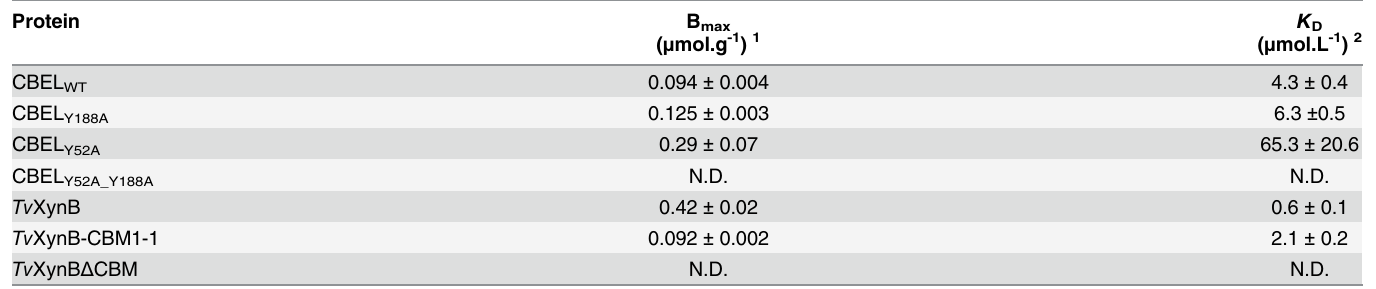
Table 1. Characterization of CBEL and Tv XynB binding to Avicel by solid state depletion assay. Protein